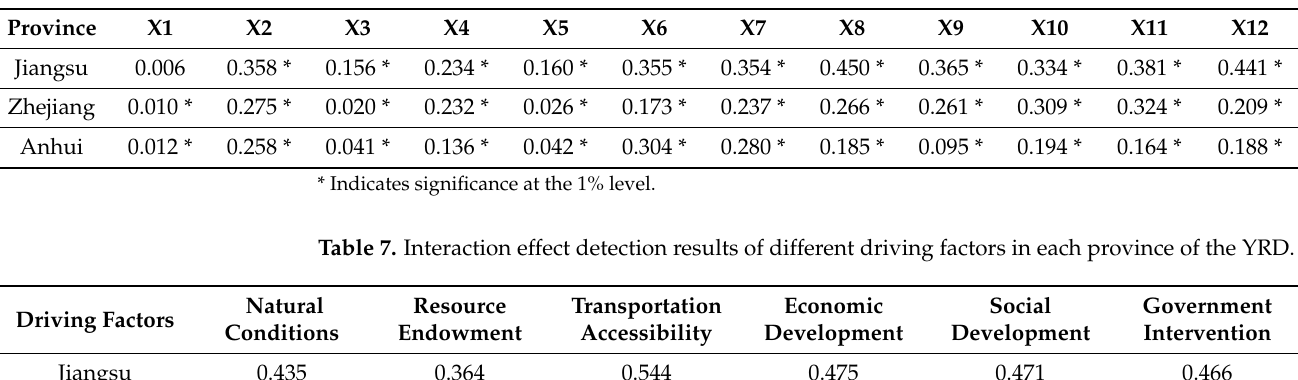
Table 6. The explanatory power of various factors on the spatial differentiation of the model villages in each province of the YRD.